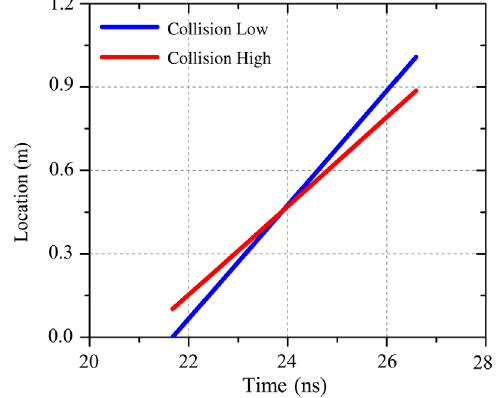
FIG. 4. Longitudinal bunch centroid evolution during an over- taking collision.